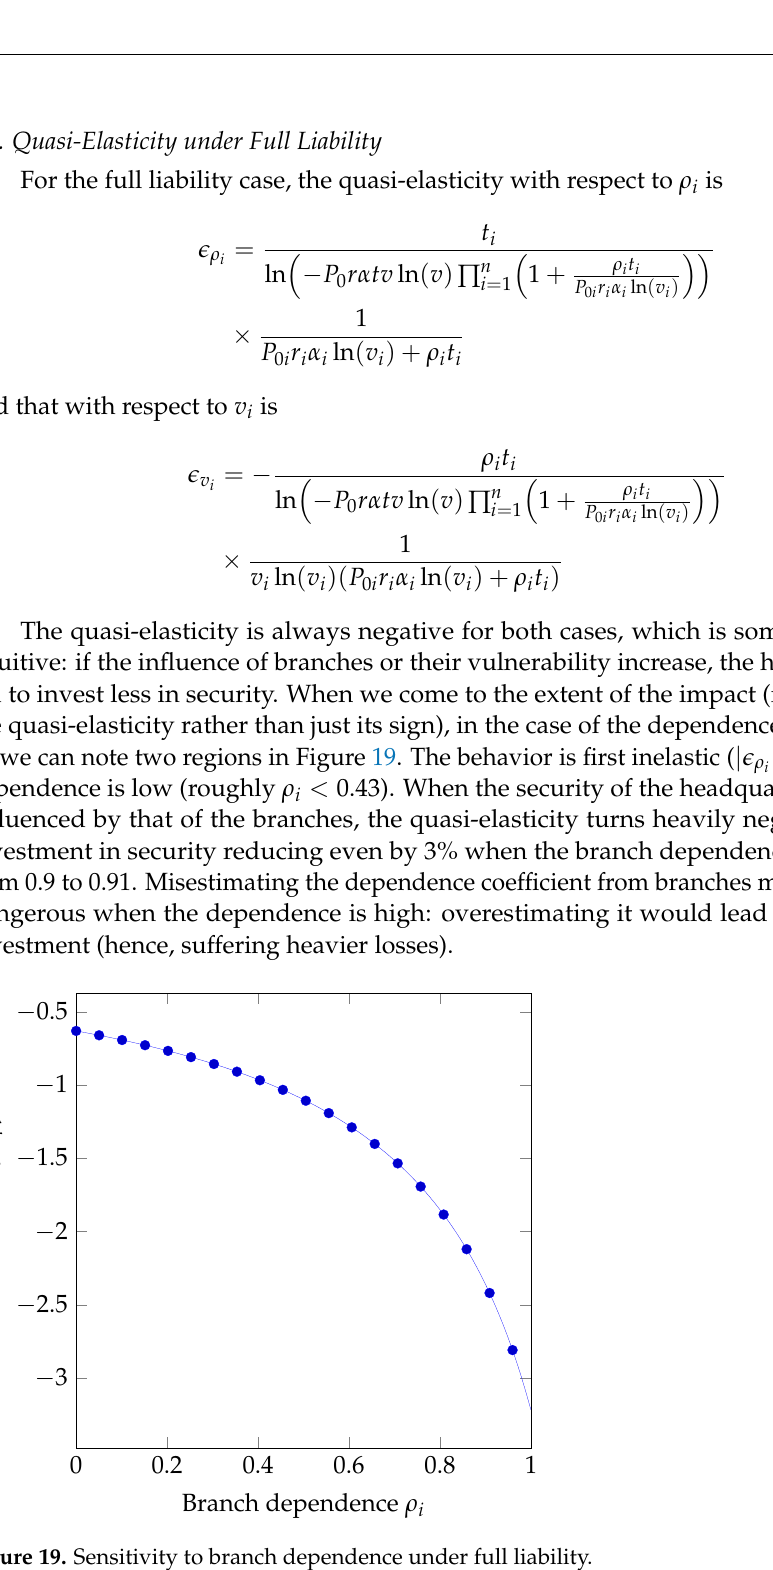
Figure 19. Sensitivity to branch dependence under full